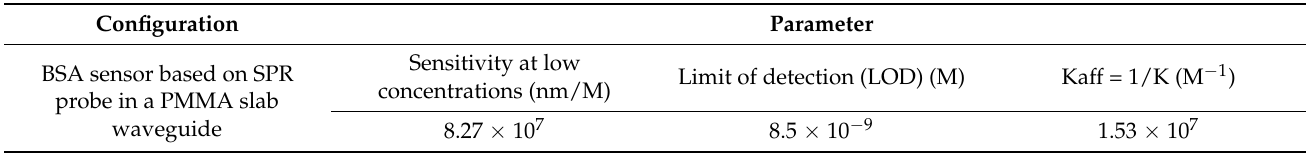
Table 2. Chemical parameters relative to the BSA detection.